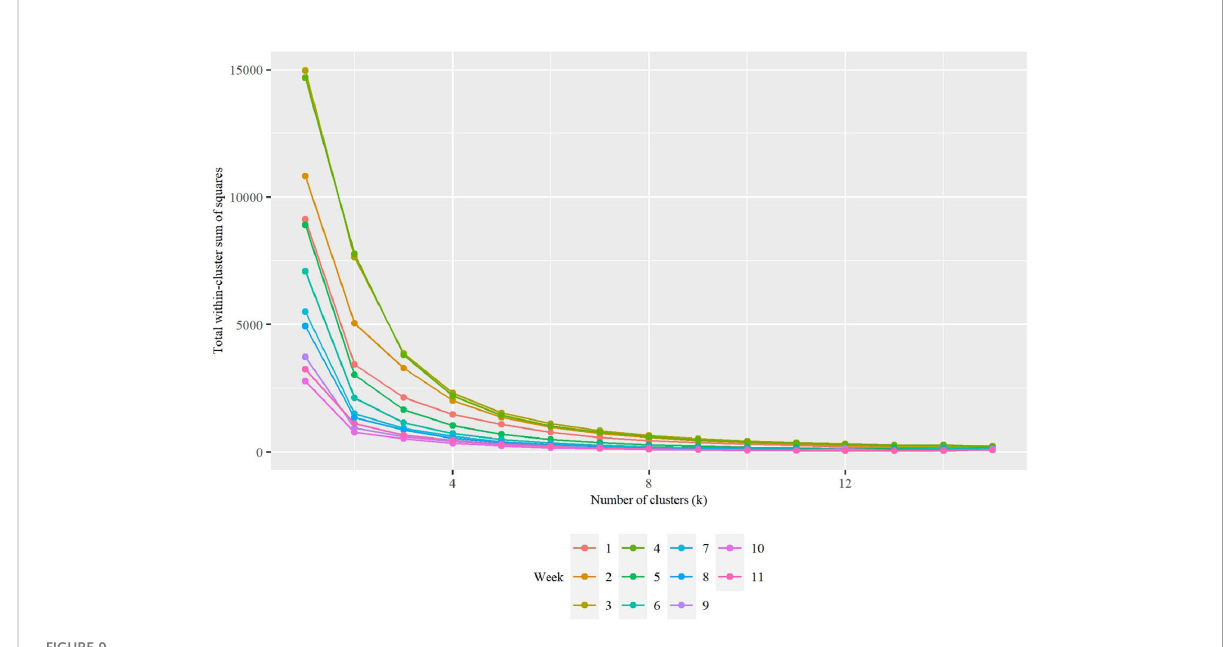
FIGURE 9 K-means clustering Elbow test results for Field B by